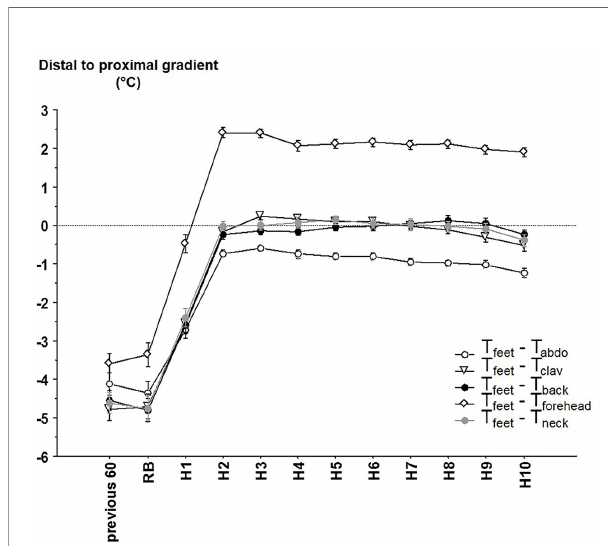
FIGURE 4 | The different distal-to-proximal skin temperature gradient (mean ± SEM) calculated between distal (i.e. feet) temperature and abdominal temperature (T abdo ), average right and left clavicular temperature (T clav ), back temperature (T back ), forehead temperature (T forehead ), neck temperature (T neck ) according to the time. Previous 60 = during the 60 min before reported bedtime (RB), H1 to H10 hours in